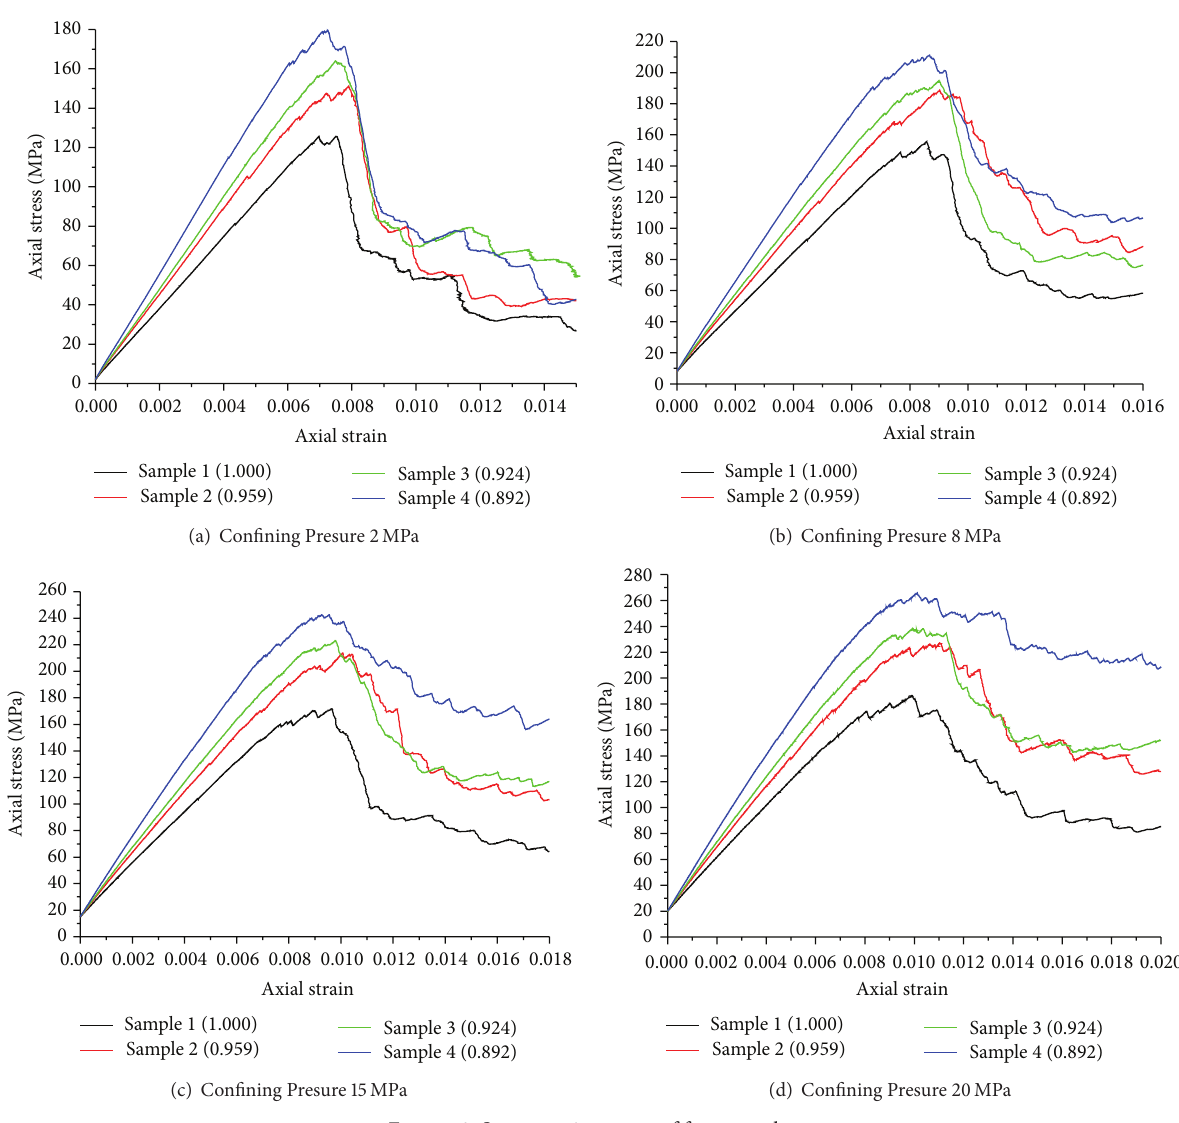
Figure 8: Stress-strain curves of four